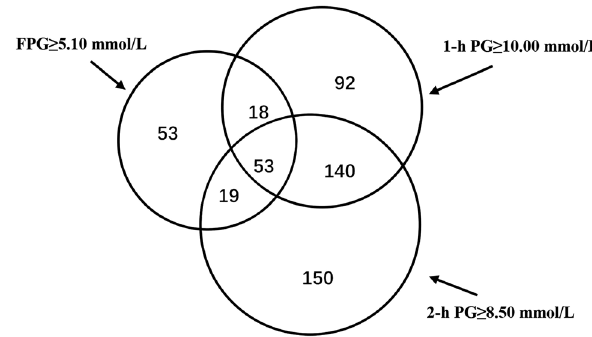
Figure 1: The incidence of gestational diabetes mellitus (GDM) among the maternal age subgroups in pregnant women.